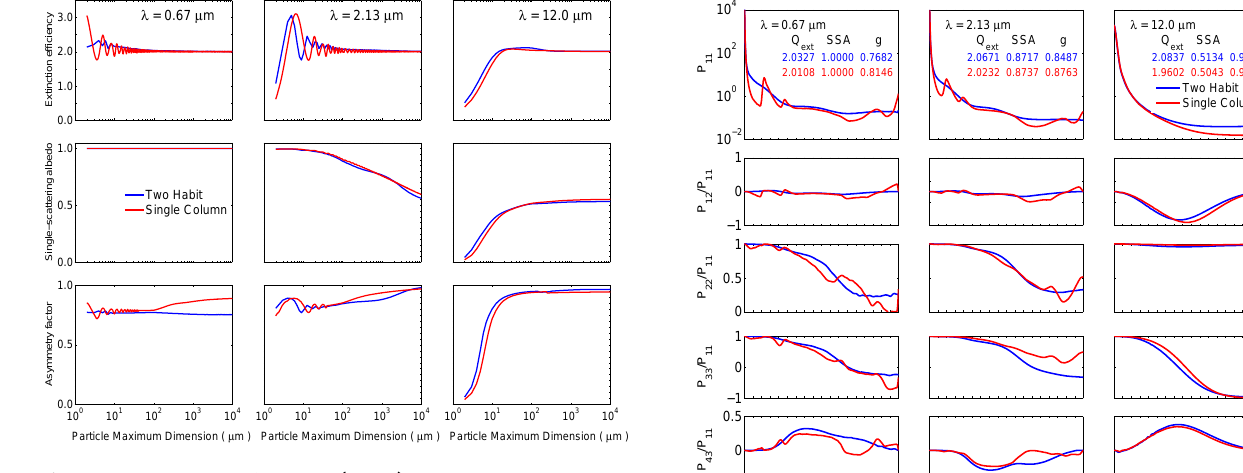
Figure 7. Extinction efficiency (upper), single-scattering albedo (middle), and asymmetry factor (lower) of the single-column and two-habit model as functions of particle maximum dimension at wavelengths of 0.67, 2.13 and 12.0µm.